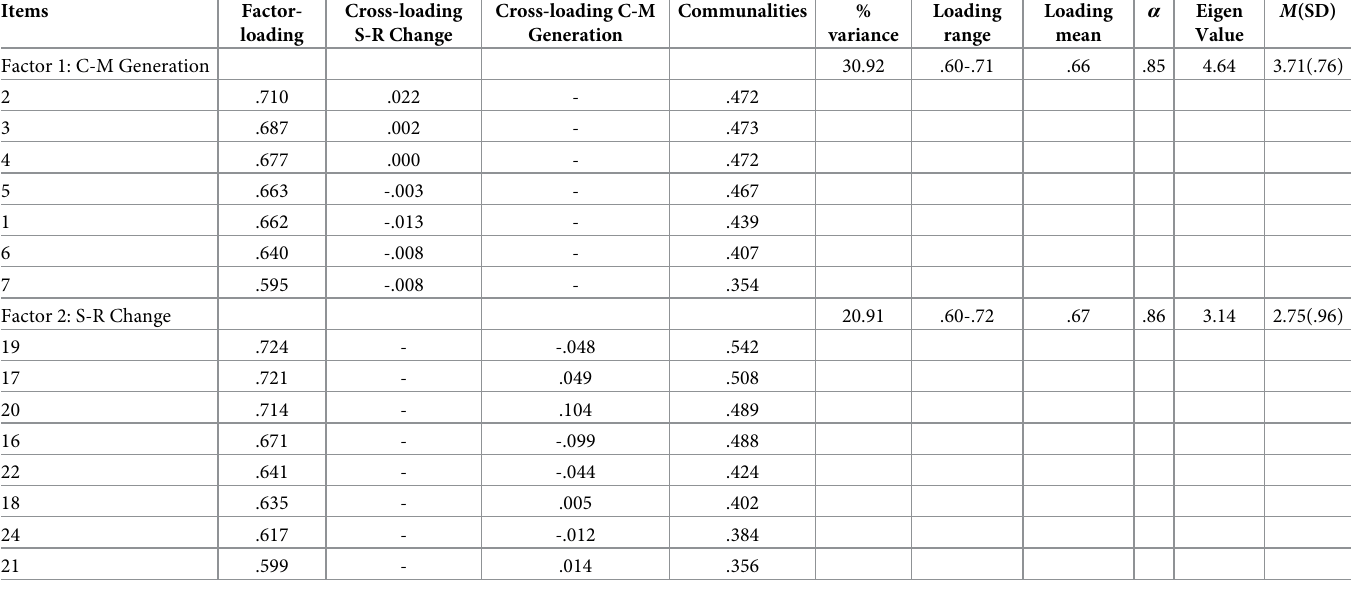
Table 1. EFA outcomes for the two-factor model, with factor loadings, cross, loadings, and communalities.